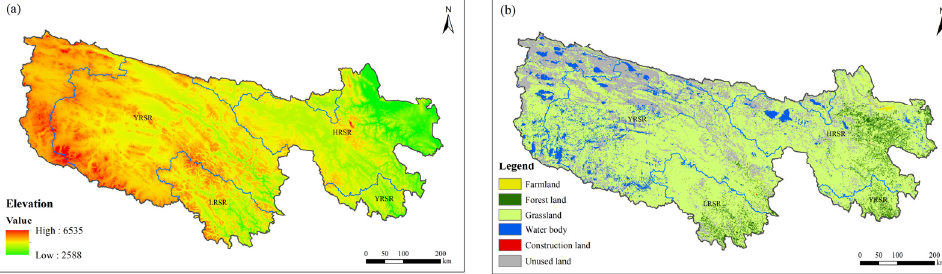
Figure 2. ( a ) Elevation and ( b ) land use distribution of the TRHR.